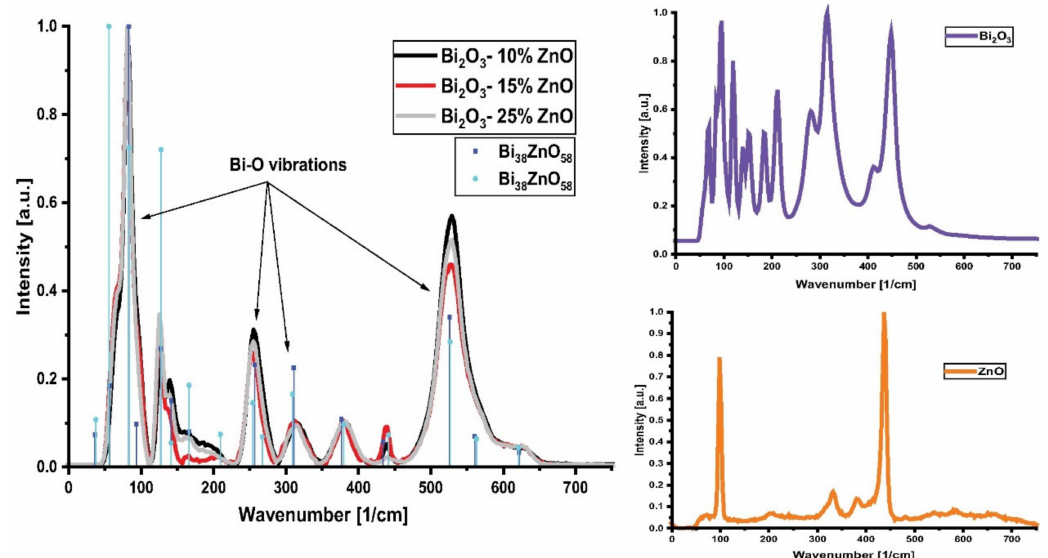
Figure 6. Raman spectra of samples; ( a ) alumina coated with mixtures of Bi 2 O 3 and ZnO and sintered at 750 ◦ C. The vertical drop lines are the peaks associated with the phase Bi 38 ZnO 58 [37]; ( b ) the Bi 2 O 3 raw material used (before sintering); ( c ) the ZnO raw material used (before